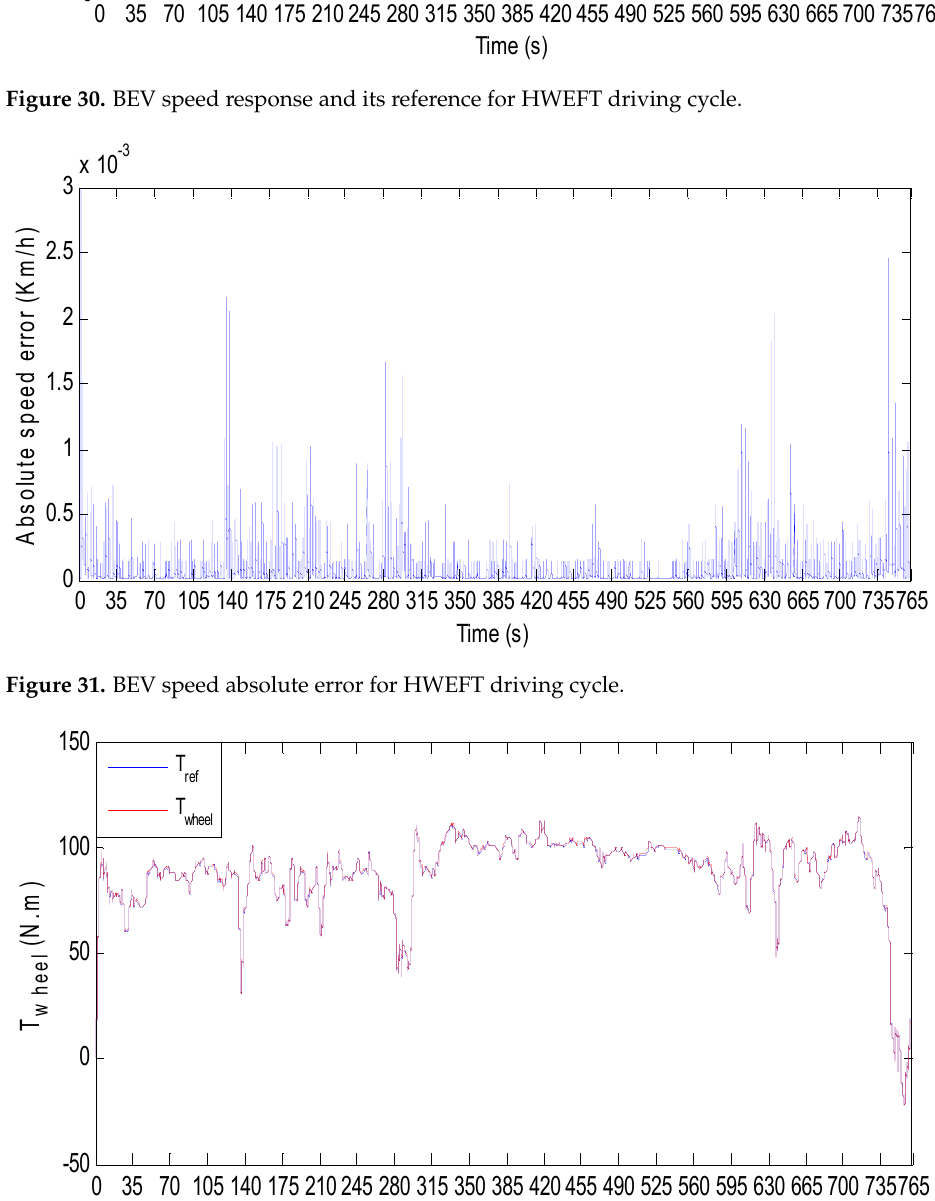
Figure 33. BEV torque absolute error for HWEFT driving cycle.